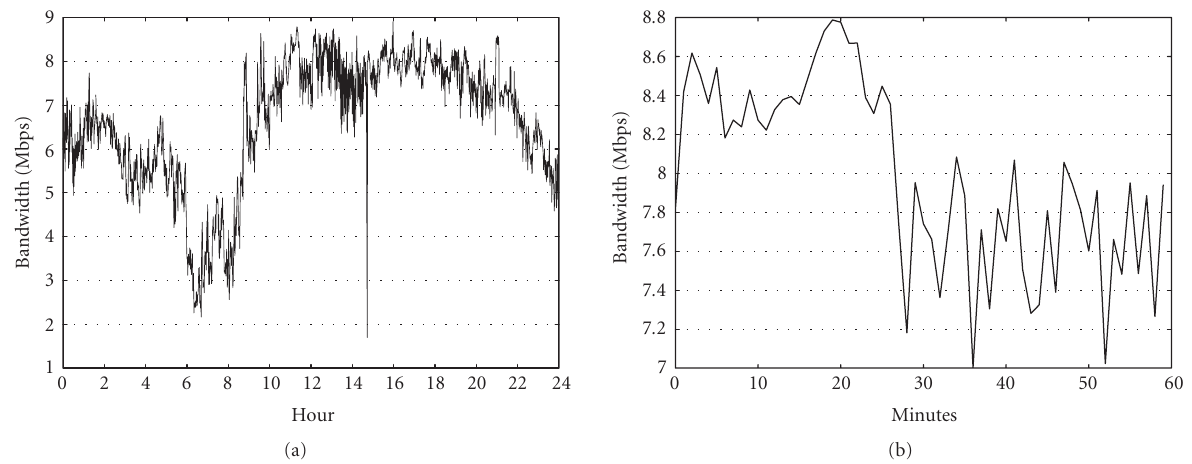
Figure 1: MAWI tra ffi c average over 1 minute interval: (a) 24-hour trace, (b) from 11:00 am to 12:00 am